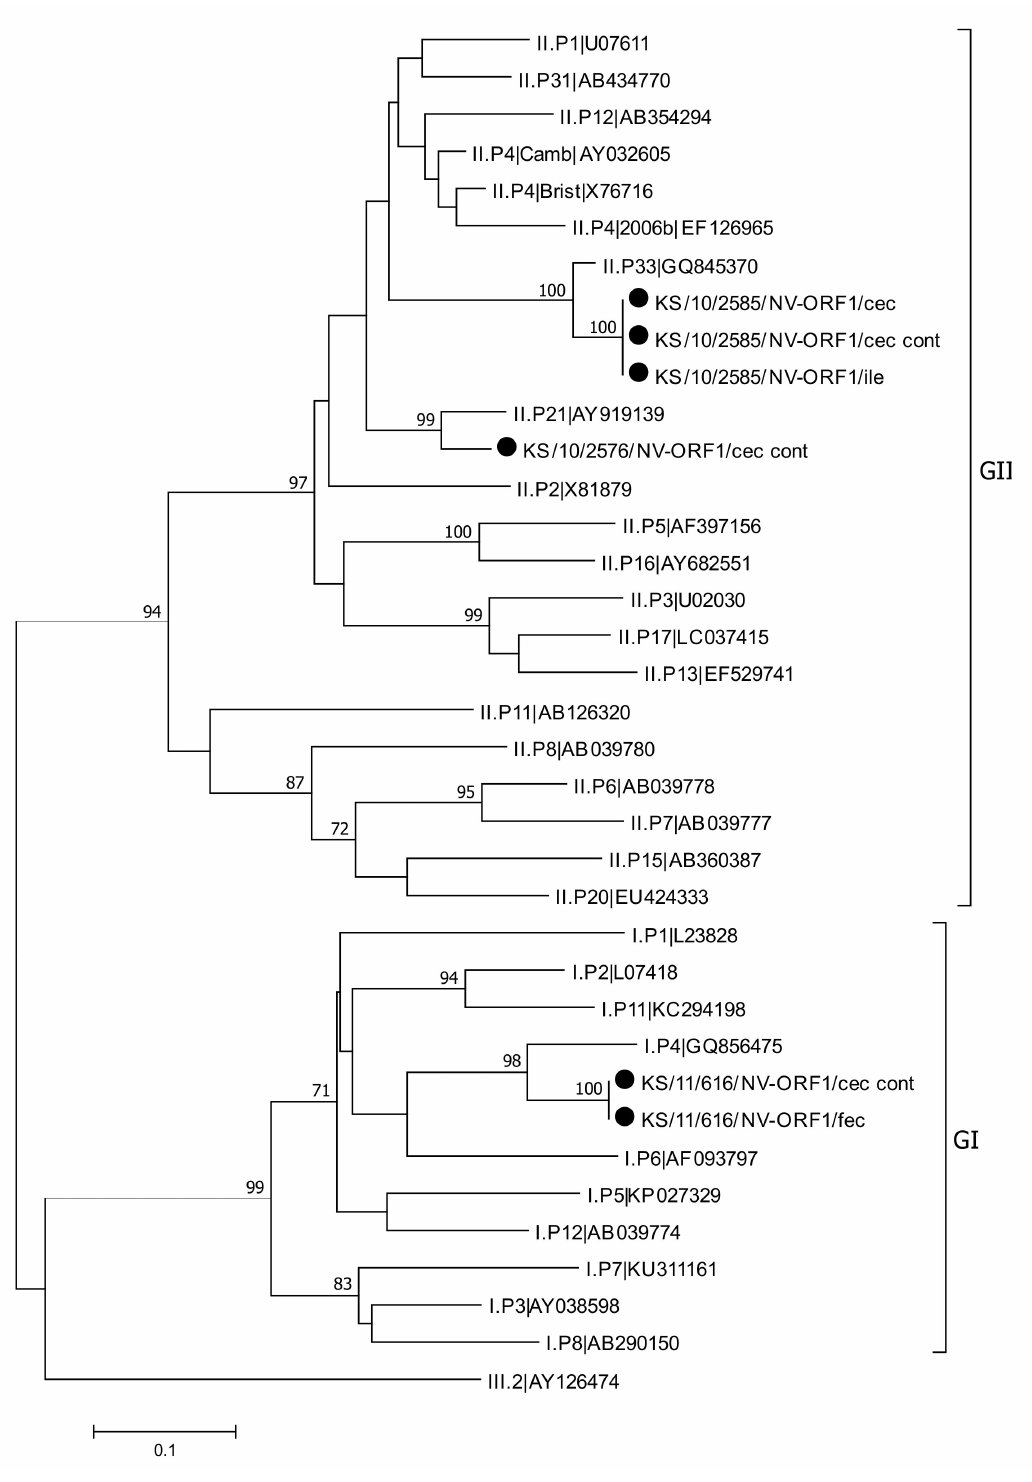
Figure 6. Phylogenetic analysis of a 263 nt fragment of ORF1 from norovirus strains detected in this study (marked with dot), human norovirus reference sequences and a single sequence that was detected in a rat from Copenhagen, Denmark (GI.P11|KC294198). The phylogenetic tree was reconstructed using the Neighbor-Joining method with Bootstrap test (1000 replicates) and the Kimura 2-parameter method available in MEGA7. The bar indicates the number of substitutions per site. Bootstraps values above 70 are shown. The bovine norovirus sequence III.2|AY126474 was used as an outgroup. Abbreviations: cec = cecum; cont = content; fec = feces; ile =